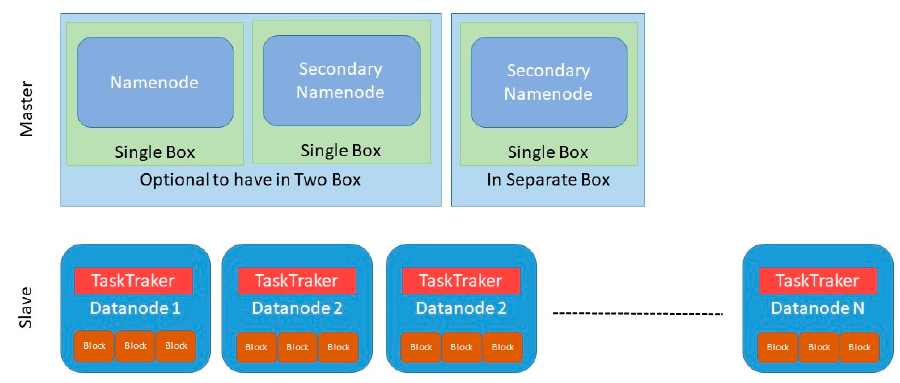
Figure 2. Architecture of a MapReduce master/slave model [13].